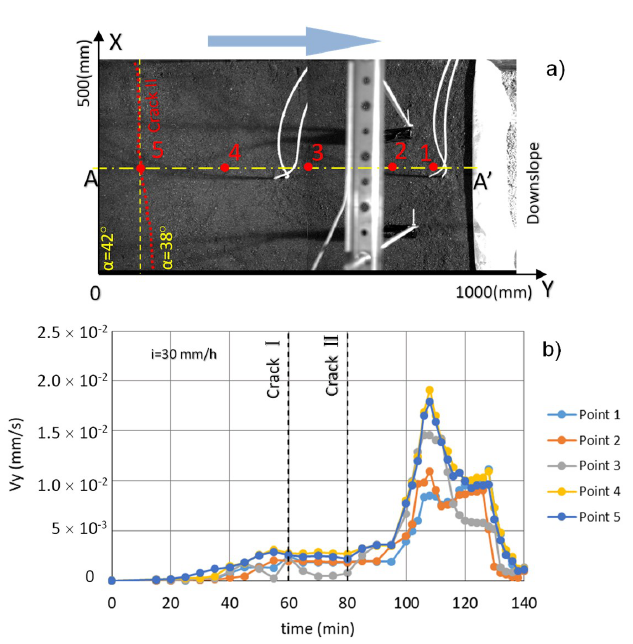
Figure 6. Particle Image Velocimetry (PIV) data: ( a ) Slope surface and section A–A (cid:48) ; ( b ) displacement rate at five points along section A–A (cid:48) .